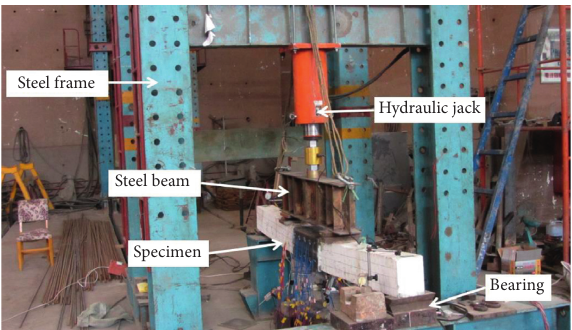
Figure 4: Test loading device.